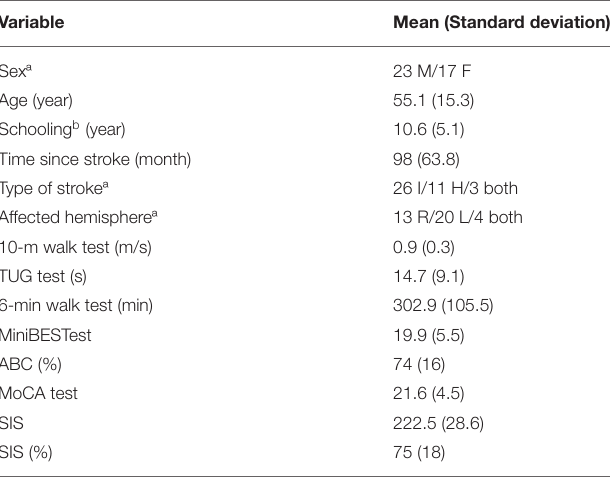
TABLE 3 | Demographic sample